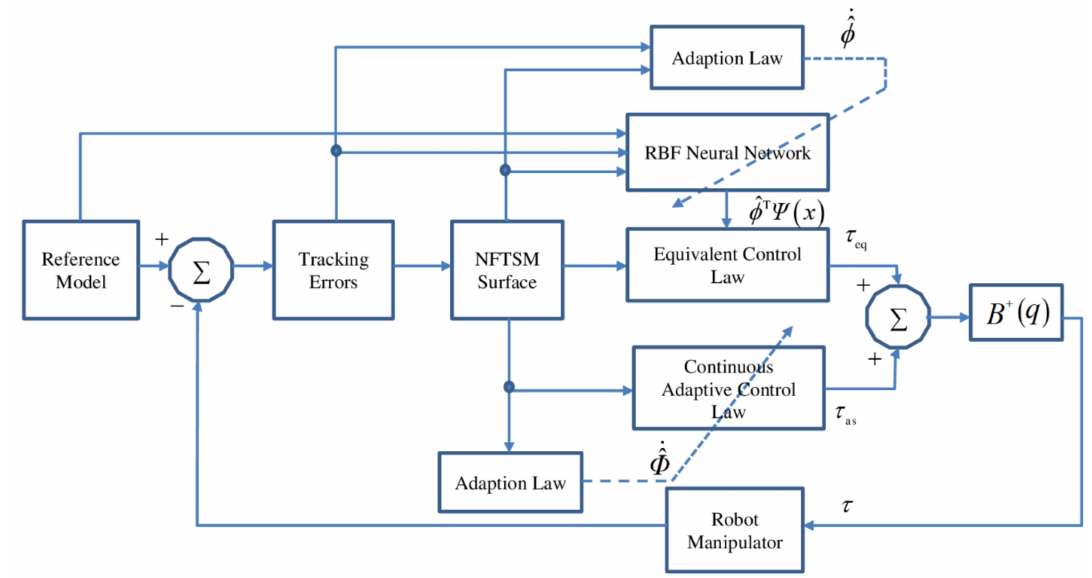
Figure 2. Block diagram of the proposed control method. RBR = radial basis function; NFTSM = nonsingular fast terminal sliding mode